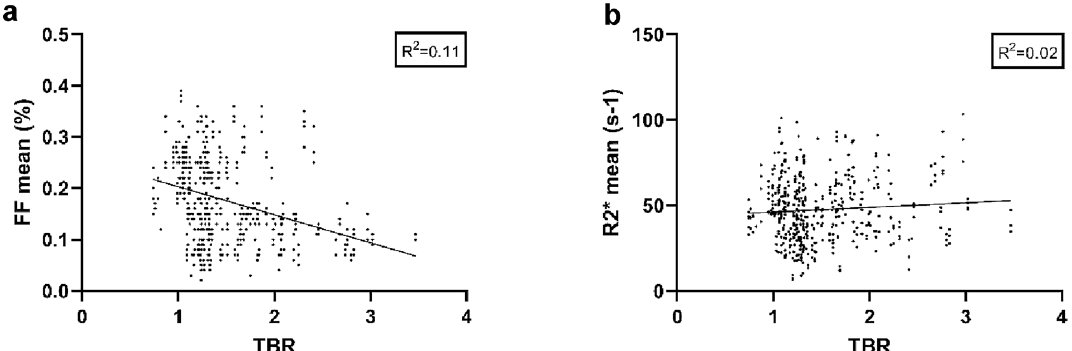
Figure 3. The figures show correlation plots, with plaque composition versus target-to-blood pool ratio. The plots illustrate plaque correlations for all 12 patients, based on the corresponding mean values in each segmented volume. ( a ) Correlations between mean FF and plaque TBR. ( b ) Correlations between R2* and plaque TBR. Simple linear regression was performed using GraphPad Prism version 9.0.0 for Windows, GraphPad Software, San Diego, California USA, www. graph pad. com. FF fat fraction, TBR target-to-blood pool